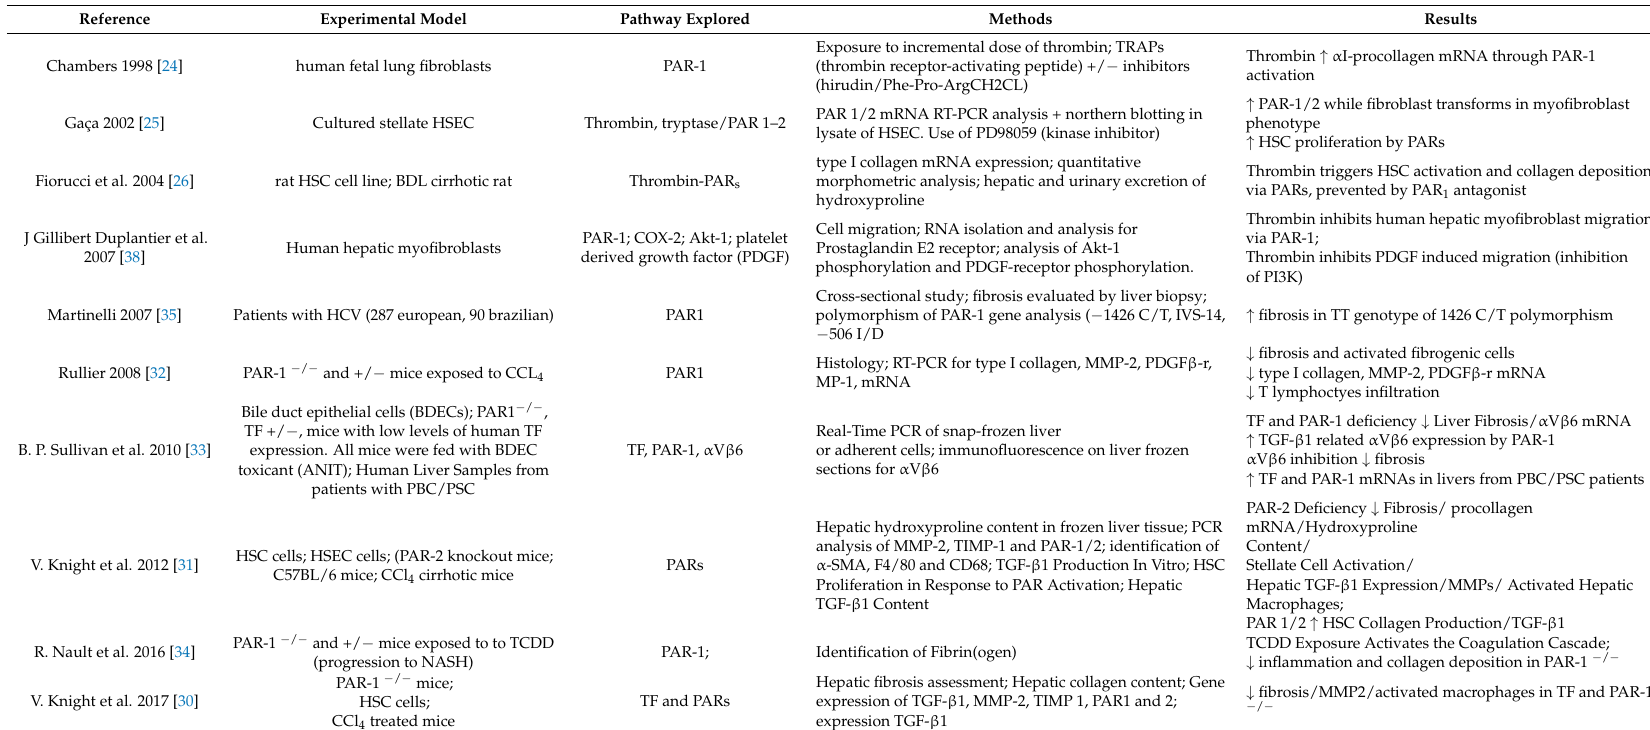
Table 1. Studies exploring the impact of coagulation on liver